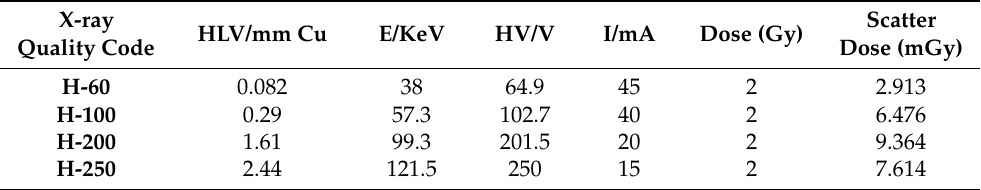
Figure 1. ( a ) Lead parallelepiped to shield the anterior two-thirds of the mouse body. ( b ) Position of the NE 2571 ionization chamber into the cap to estimate the scatter dose to the shielded heart. ( c ) Workflow of experimental endpoints after mice irradiation. Table 1. Summary of the experimental measurements with the NE 2571 ionization chamber. Values of scatter doses to the heart at 60, 100, 200 and 250 kVp.